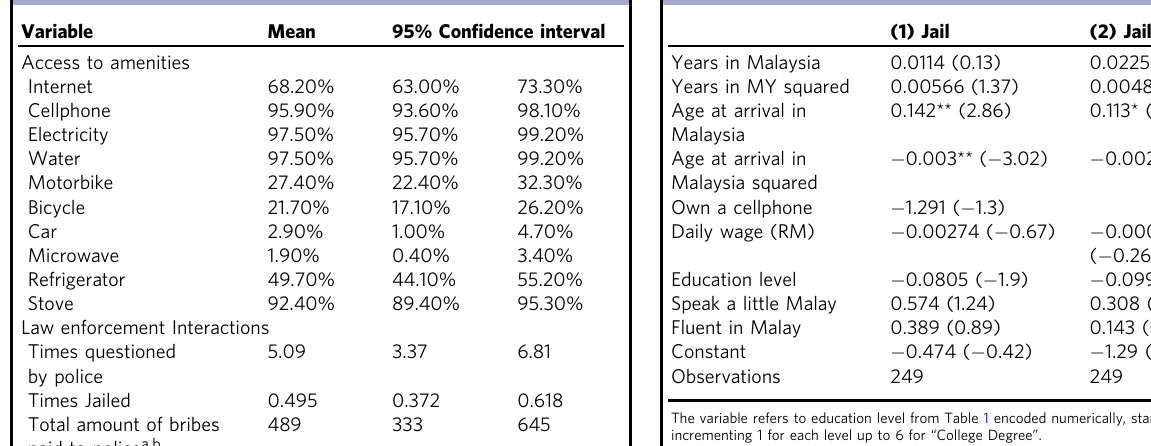
Table 2 Security and amenities. Table 3 Correlates of